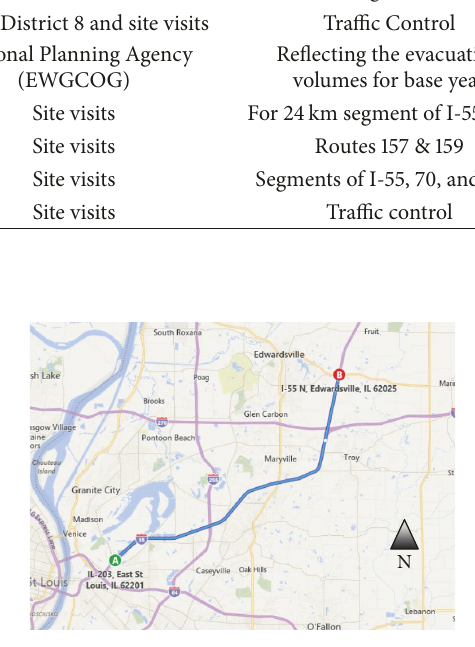
Figure 2: Calibration Segment. Not to